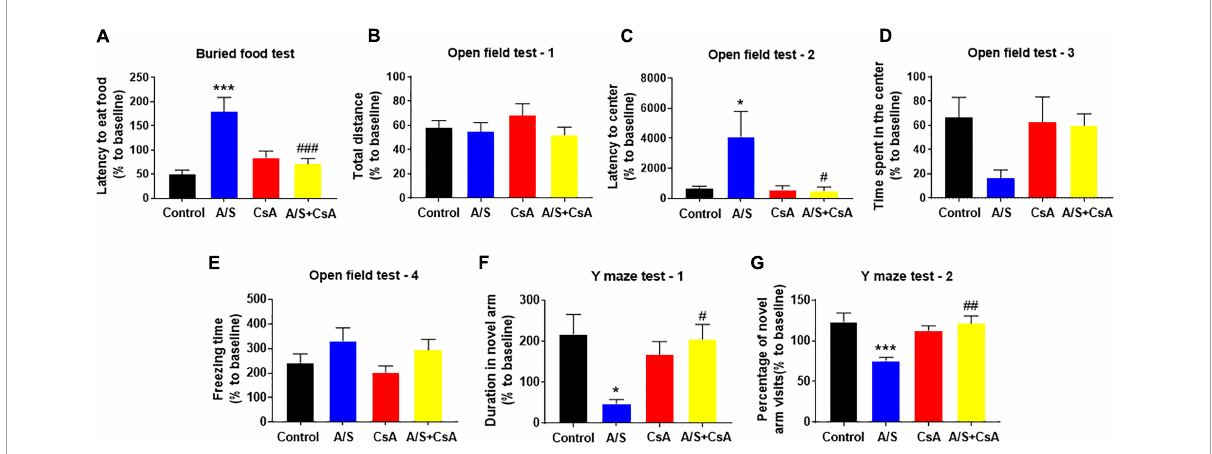
FIGURE5 Effects of CypA/MMP9 pathway on anesthesia/surgery-induced delirium-like behavior in mice. Inhibition of CypA/MMP9 pathway improves anesthesia/surgery-induced delirium-like behavior. In the buried food test, CsA decreased the latency to eat food in mice (A) . In the open field test, anesthesia/surgery had no influence on total distance (B) , time spent in the center (D) or freezing time (E) . CsA decreased the latency to center (C) in mice. In the Y maze test, CsA increased the duration in novel arm (F) and the percentage of novel arm visits (G) in mice with delirium-like behavior, which is induced by anesthesia/surgery. Data are expressed as mean ± SEM and were analyzed by one-way analysis of variance, followed by Tukey’s post-hoc test. The control and A/S groups are shared between Figure 3 . n = 10 per group. A/S, anesthesia/surgery. * P < 0.05, *** P < 0.001, compared to control group; # P < 0.05, ## P < 0.01, ### P < 0.001, compared to A/S